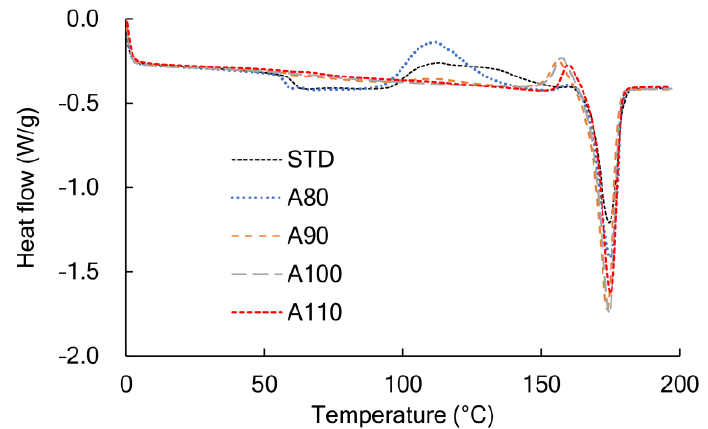
Figure 3. DSC curves during heating at 10 ◦ C/min for the annealed